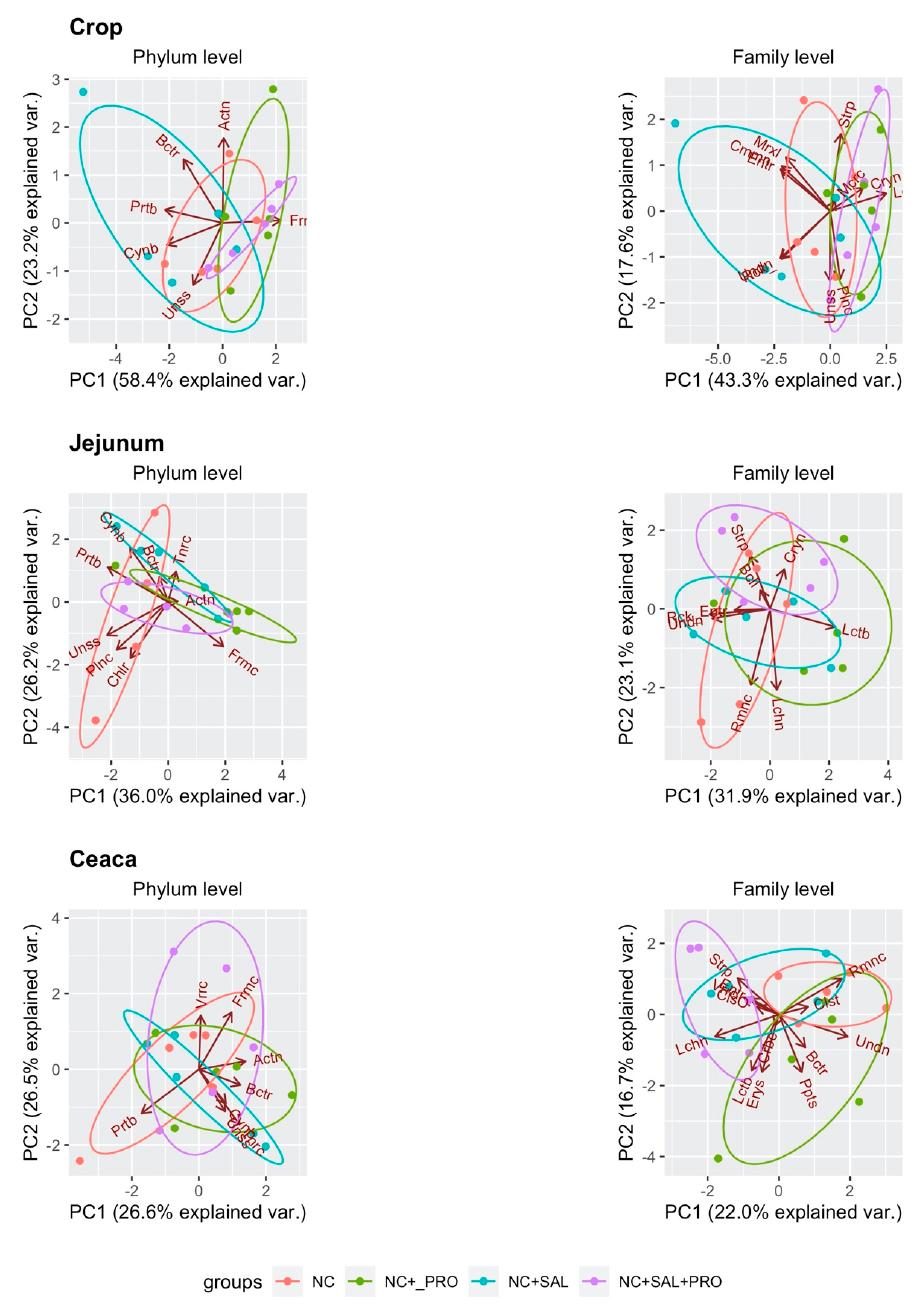
Figure 2. Principal component analysis (PCA) plot of the obtained sequence from the crop, jejunal, and cecal digesta samples: NC—control diet with no additives; NC + PRO— B. licheniformis preparation (1.6 × 10 9 CFU / kg diet); NC + SAL—salinomycin addition (60 ppm); NC + SAL + PRO—a mixture of salinomycin (60 ppm) and B. licheniformis (1.6 × 10 9 CFU / kg diet); means represent 10 pens of one chick each pooled by two ( n = 5).